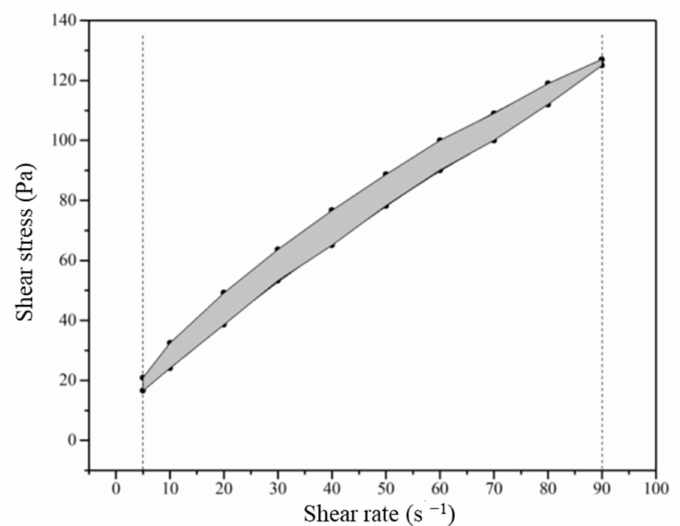
Figure 4. Thixotropy of the paste calculated from the shade